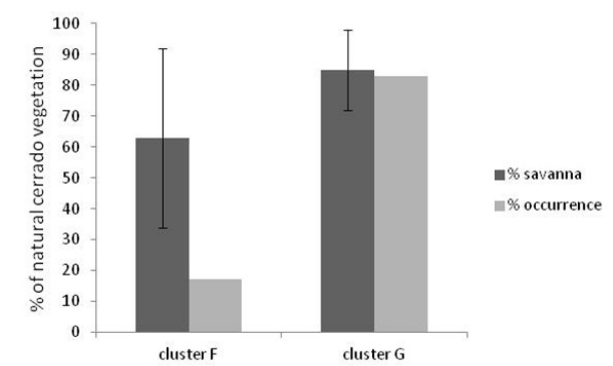
Fig 4. Percentage and standard deviation of natural cerrado vegetation in cluster F and G (dark gray) and percentage of occurrence of Melipona species (light